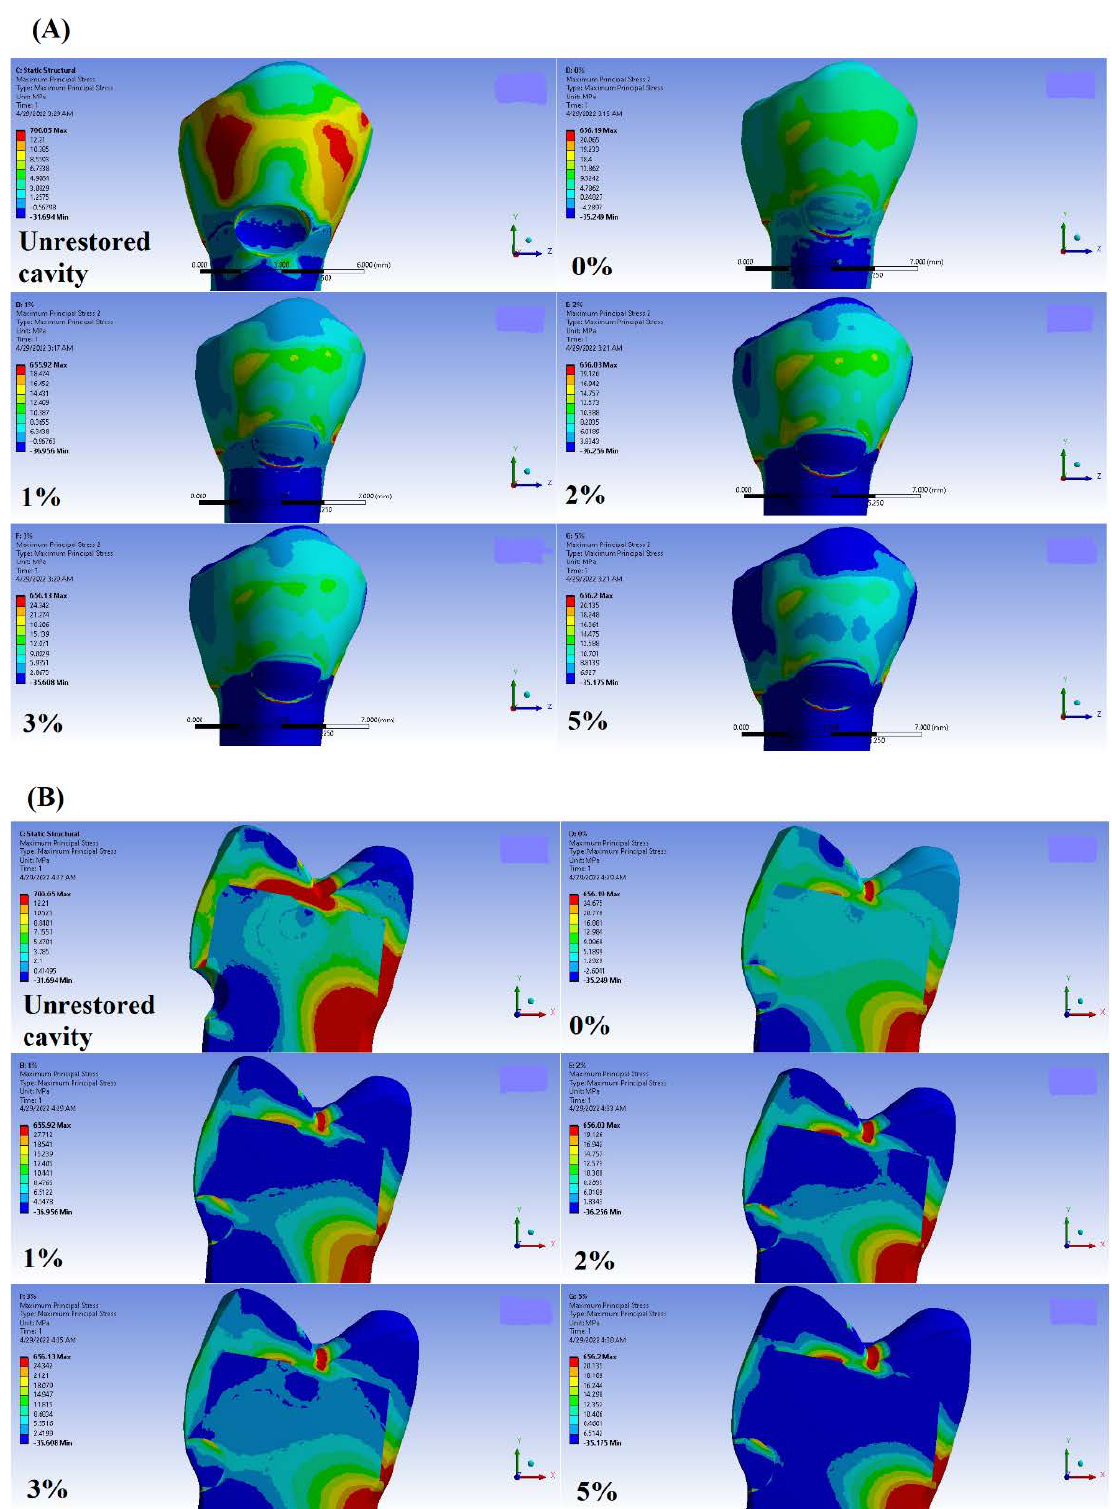
Figure 4. Maximum Principal Stress distribution (MPa) in Buc.L loading site. ( A ) Buccal view, ( B ) Mid-cut view. similar patterns of stress distribution with different magnitudes are observed among various loading conditions.